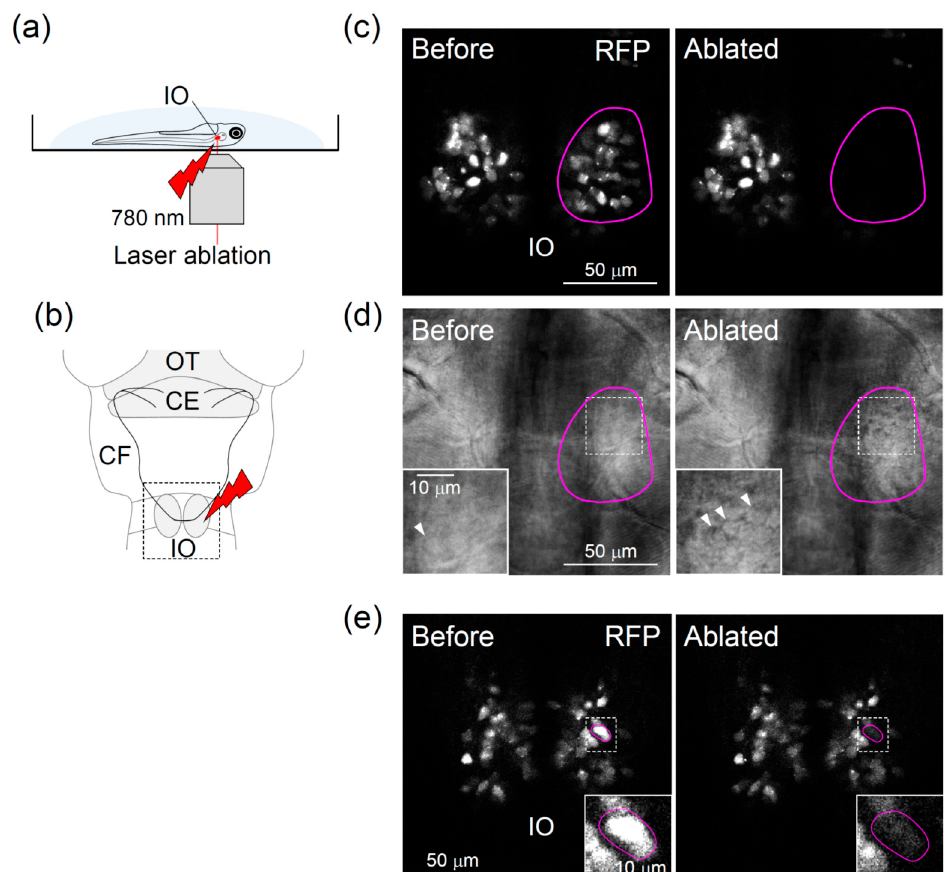
Figure 2. Two-photon laser ablation of the inferior olive in zebrafish: ( a ) Schematic diagram of the laser ablation system. ( b ) Right hemisphere of the inferior olive was irradiated. CE, cerebellum; CF, climbing fiber; IO, inferior olive; OT, optic tectum. ( c – e ) Images of the inferior olive neurons before (left) and shortly after (right) laser irradiation. Red circles indicate the target area of irradiation. The arrowheads in the magnified images in ( d ) indicate neurons that showed abnormal morphology after laser irradiation ( d ,